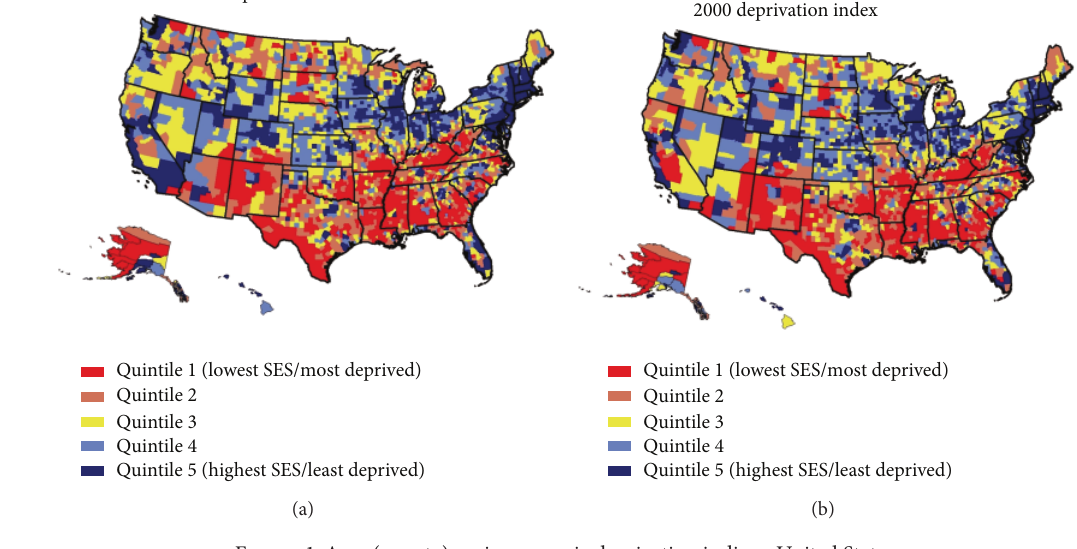
Figure 1: Area (county) socioeconomic deprivation indices, United States.